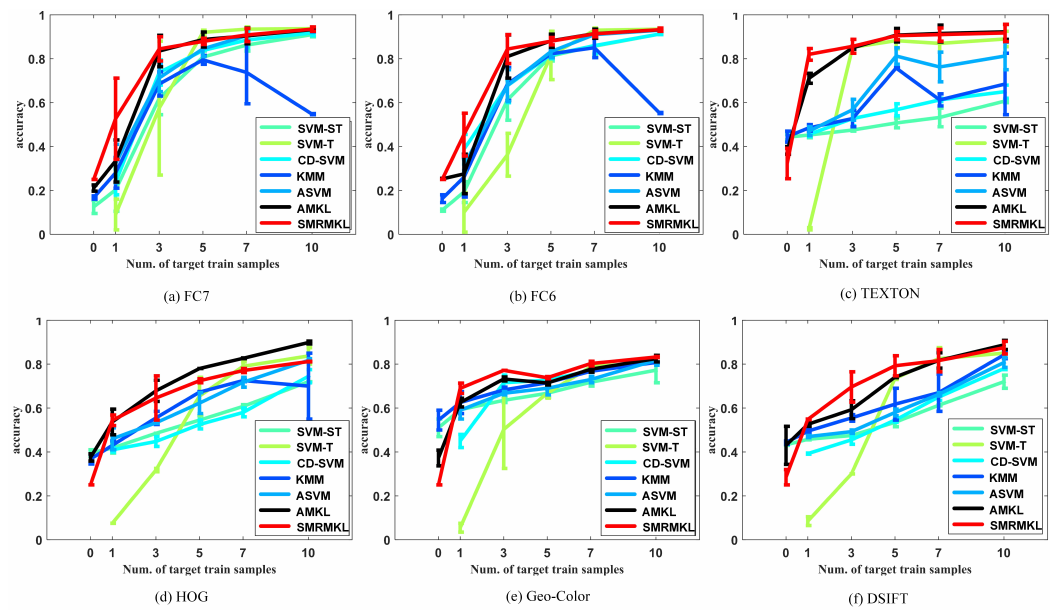
Figure 6. The performance (means and standard deviation of overall accuracy) of different approaches with different features for S1 → T3 transfer task.